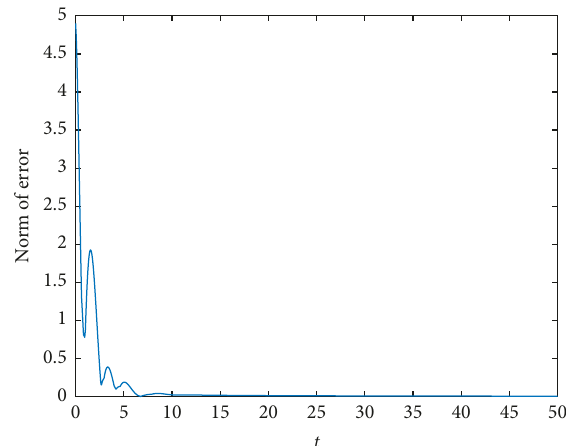
Figure 4: Time evolution for the norm of error in Example